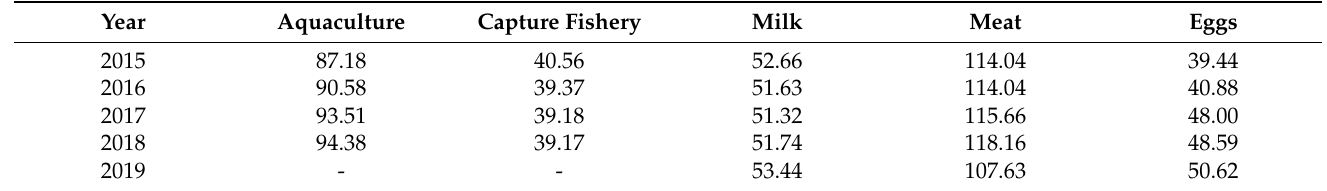
Table 2. Animal-based protein production in East and Southeast Asia (million